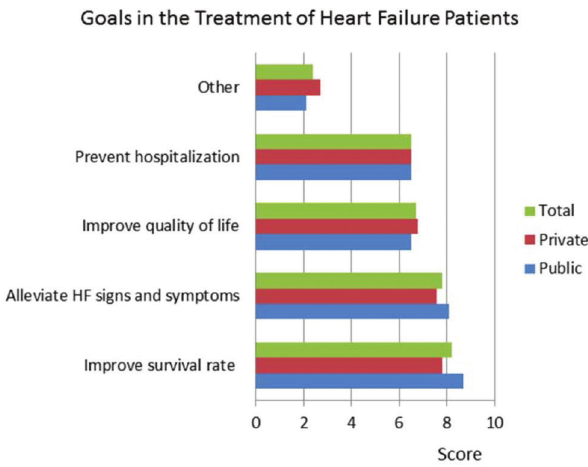
Figure 2 - Perceptions of doctors in centers treating heart failure (HF) patients about goals of HF treatment using a score for total, private, and public settings.